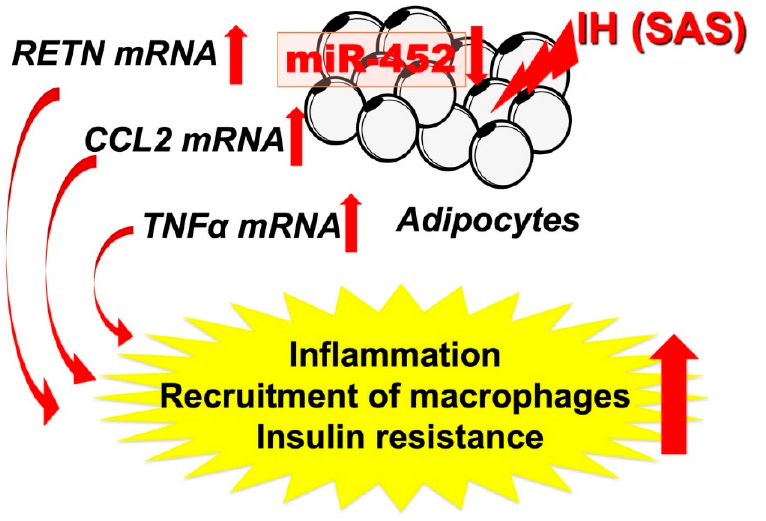
Figure 2. IH-induced increases in RETN, TNF α , and CCL2 via downregulates the miR-452 in adipocytes. It is suggested that, in SAS patients, the upregulation of RETN , TNF α , and CCL2 [7] may induce a proinflammatory phenotype of the adipose tissue, leading to the development of insulin resistance and reduced insulin sensitivity, and miR-452 could play crucial roles in the regulation of these gene expressions. Red up and down arrows mean increment and decrease,